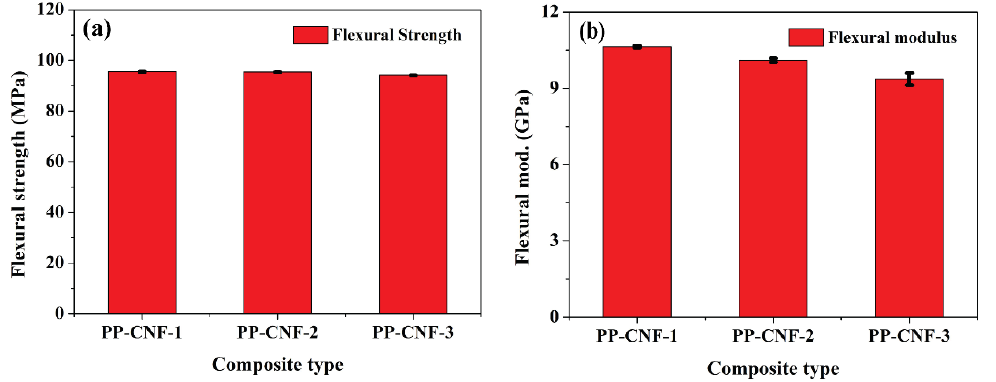
Figure 2. Three-point bending testing results of PP-CNF nanocomposite according to ASTM D790 standard and showed the plot of ( a ) Flexural strength and ( b ) Flexural modulus variation of PP-CNF nanocomposite.